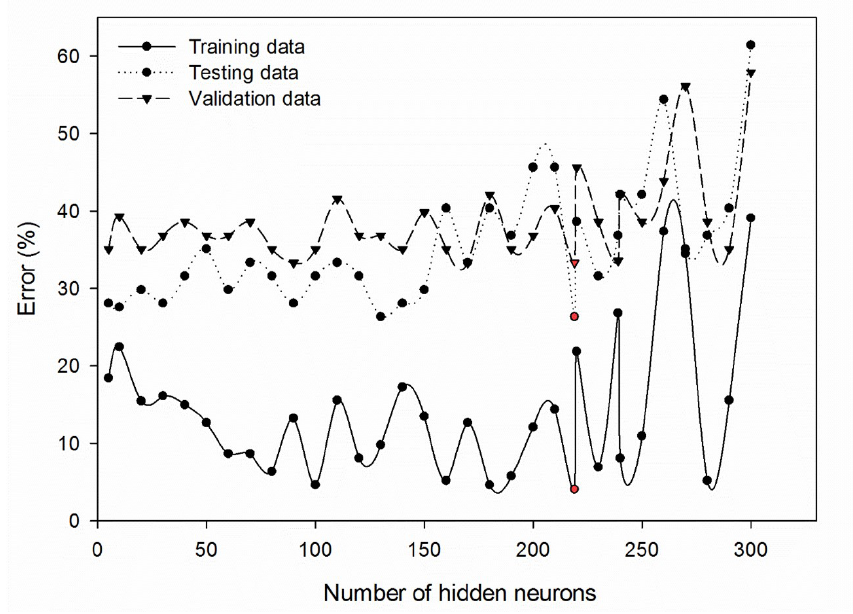
Figure 2. Training, testing, and validation errors for the image configurations of 1/8 threshold limit, 35 pixels circle radius, and green and NIR bands for various numbers of hidden neurons.